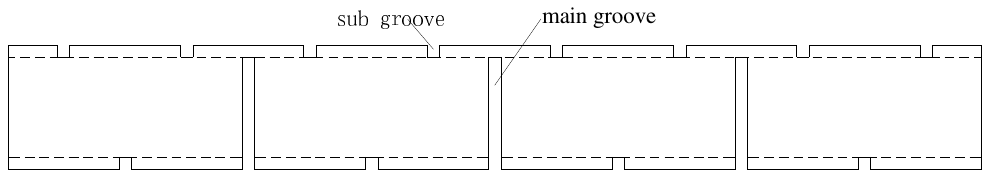
Figure 7. Front view of grooved polymethylacrylic imide (PMI) foam.